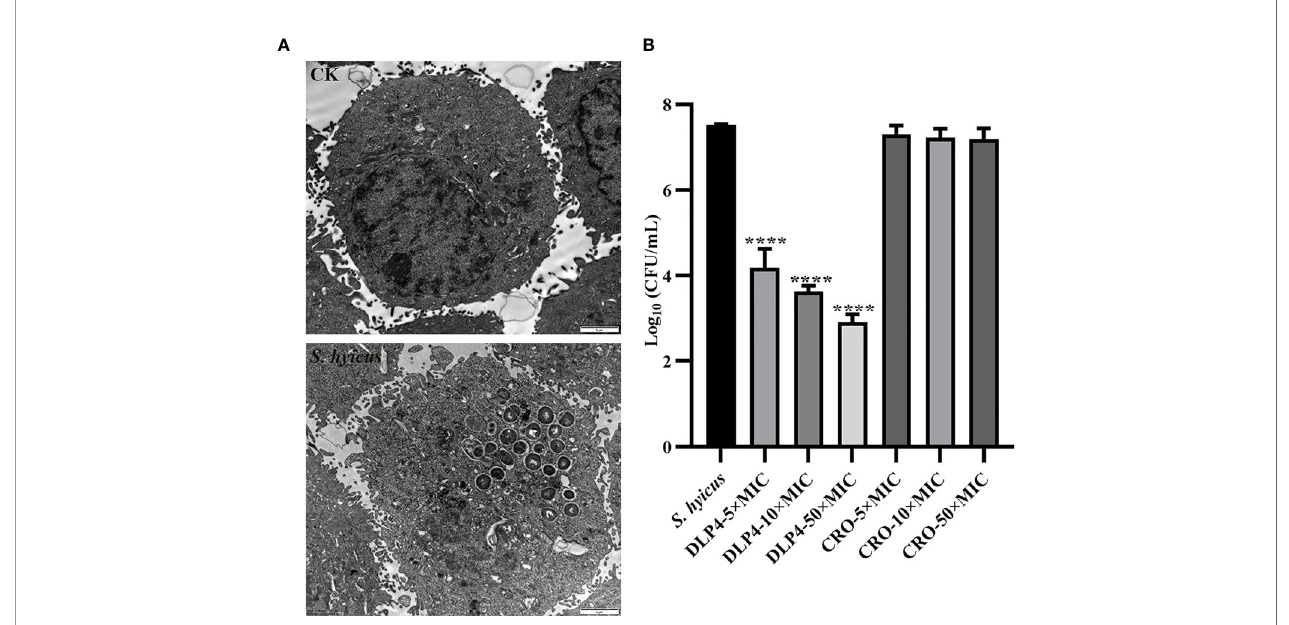
FIGURE 2 | Intracellular bacteriostatic ef fi cacy of DLP4. (A) Morphologies of S. hyicus ACCC 61734 in HaCaT cells; (B) Intracellular antibacterial activity against S. hyicus ACCC 61734, results were given as mean ± SD (n = 3). All data were analyzed by the one-way ANOVA and Bonferroni multiple comparison. ****P <